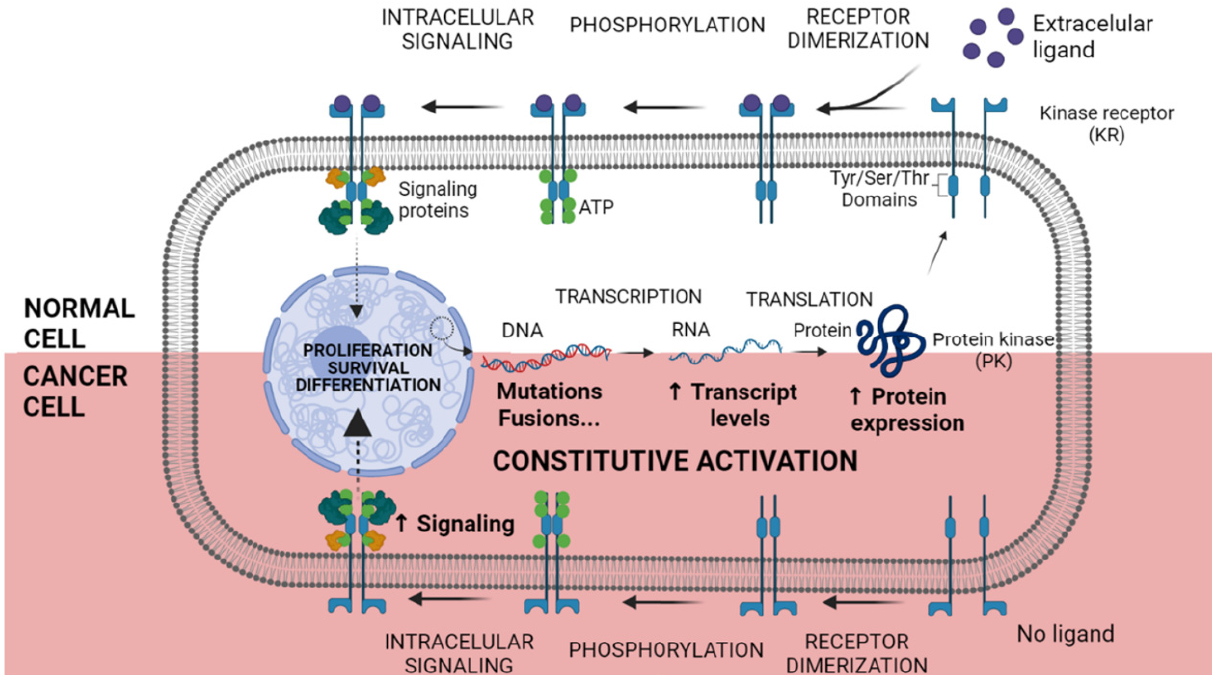
Figure 2. Constitutive activation of Kinase Receptor mechanism. In normal cells, after transcription and translation, Kinase Receptors (KR) are sent to the cellular membrane. In the presence of an extracellular ligand, the KR dimerization occurs and the Tyrosine (Tyr), Serine (Ser) or Threonine (Thr) domains are autophosphorylated. Signaling proteins are attached to the phosphorylated amino acid residues, and the downstream signalization begins. Otherwise, in cancer cells, genetic and chromosomal alterations lead to enhanced RNA and protein overexpression. Malignant cancer cells do not depend on an extracellular ligand to initiate the signaling process, being constitutively active and boosting tumoral phenotype. Created with BioRender.com, accessed date: 20 August